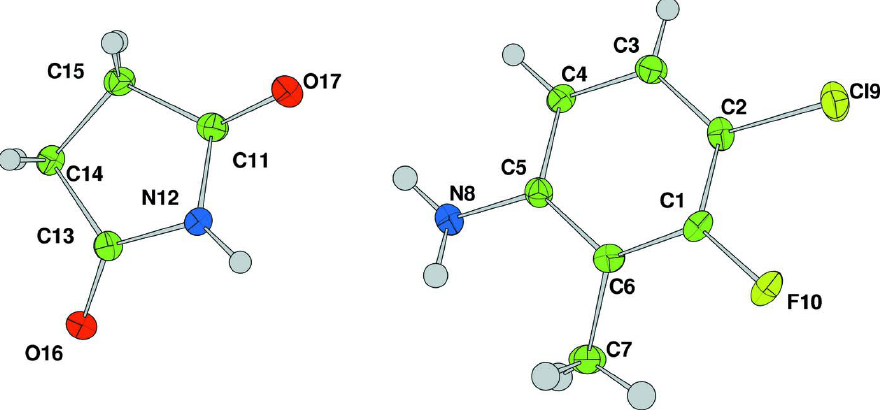
The title compound with displacement ellipsoids drawn at the 50% probability level. H atoms are shown as spheres of arbitary